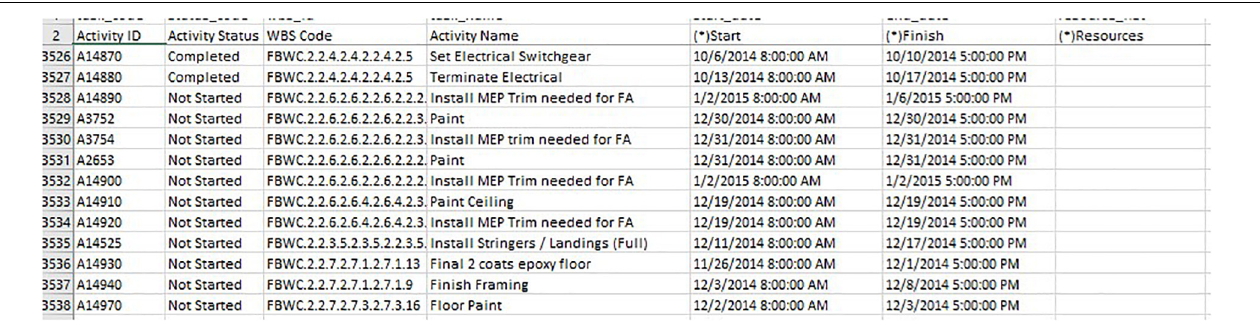
more-or-less automatically figure out what trade was involved.